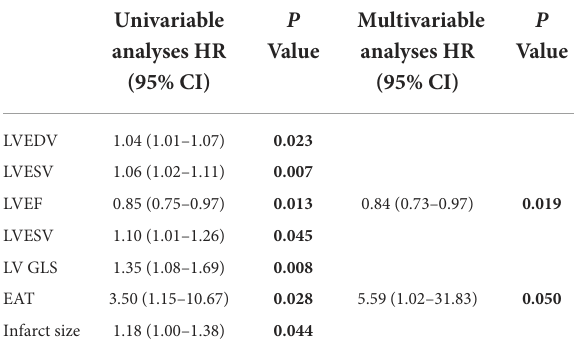
TABLE 3 Univariable and multivariable logistic regression analyses. TABLE 4 Cox regression analysis for MACE.